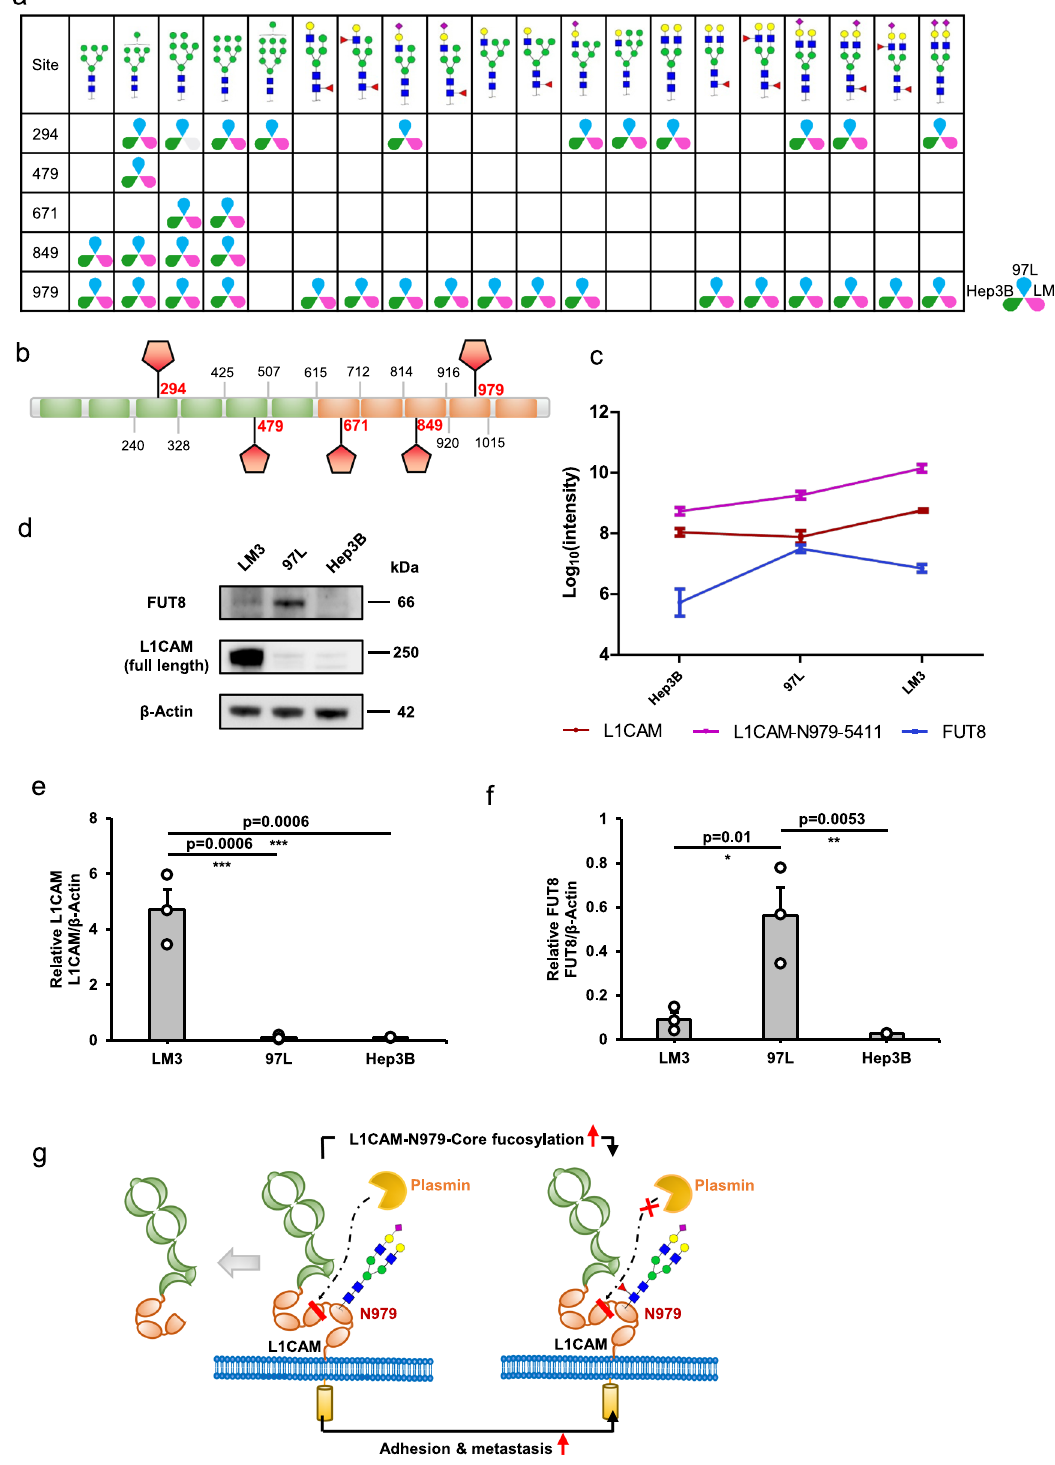
Fig.6|Site-979-speci fi ccorefucosylationofL1CAMisupregulatedinthreeHCC cell lines with increasing metastatic potential. a Site-speci fi c N -glycosylation of L1CAMinthreeHCC celllines. b Graphicalviewof fi ve identi fi ed glycositeslocated inspeci fi cpositionsanddomainsofL1CAM.TheorangebarchartrepresentstheIg- likeC2type,andthegreenbarchartrepresents fi bronectintypeIII. c Changetrends of protein L1CAM, site-979-speci fi c glycan Hex[5]HexNAc[4]NeuAc[1]Fuc[1] (L1CAM-N979-5411), and protein FUT8 in three HCC cell lines from no metastatic potential to high metastatic potential. Data are presented as mean values±SD. ( n =4 biological replicates) ( d ) Western blot validation of the protein expression